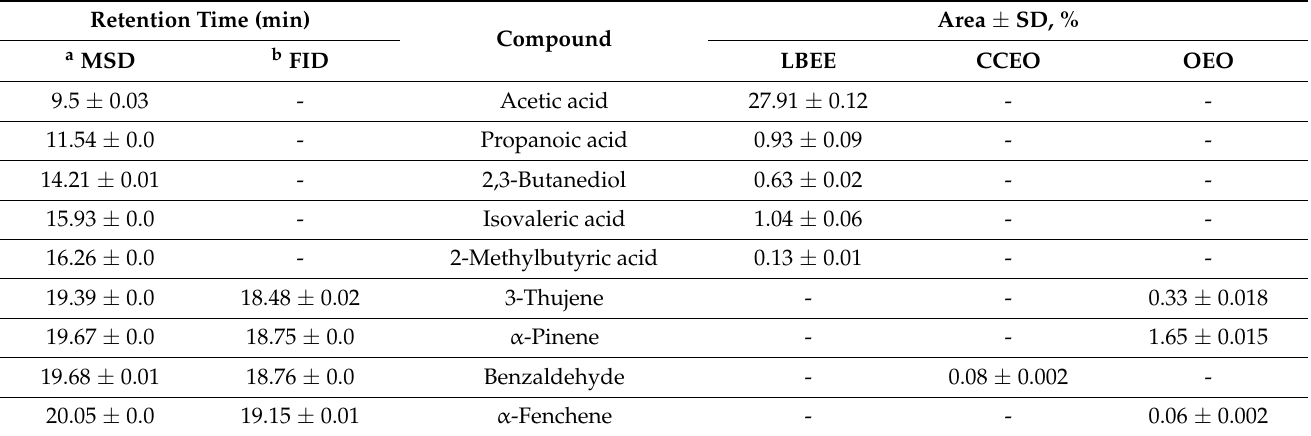
Table 2. Chemical composition of leather bergenia ethanolic extract, Chinese cinnamon, and oregano essential oils. a MSD—Mass Spectrometric Detector; b FID—Flame Ionization Detector. The